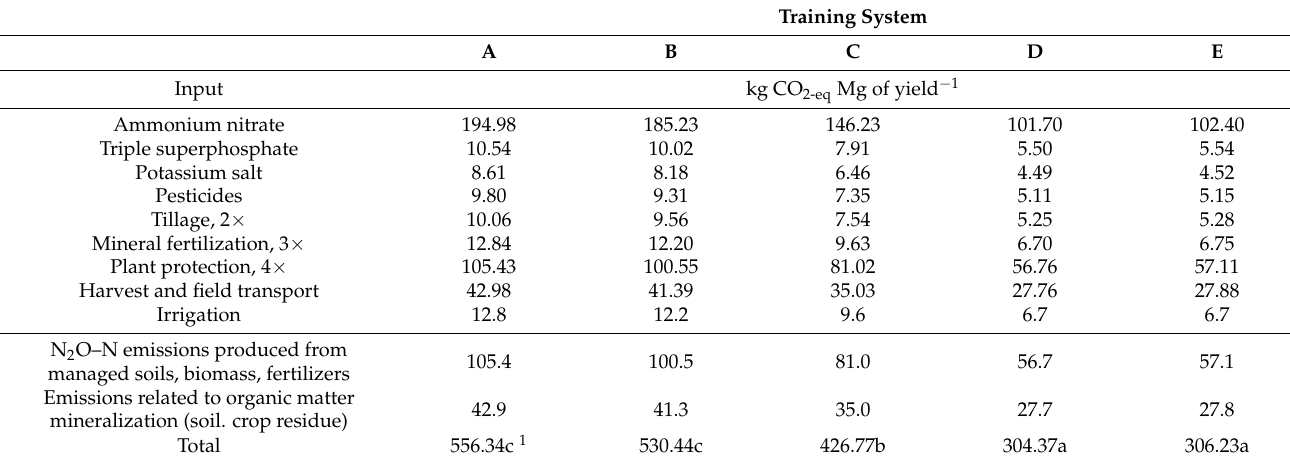
Table 9. Mean annual GHG emissions and energy consumption associated with agricultural treatments, fertilizers, pesticides, and vineyard planting calculated for 1 Mg of yield in period 2001–2020 (kg CO 2-eq Mg of yield − 1 ).